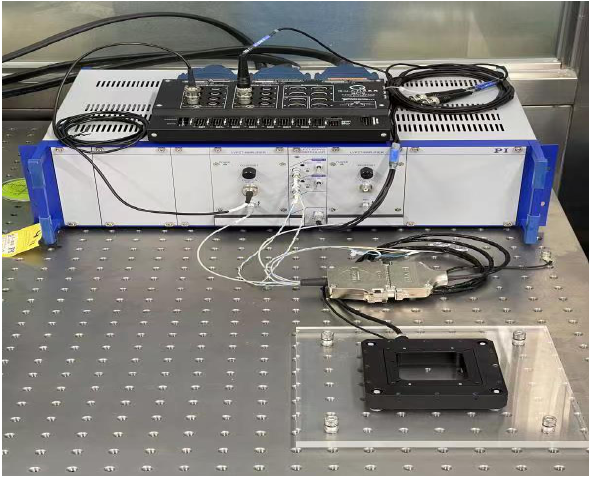
Figure 4. Experimental equipment.